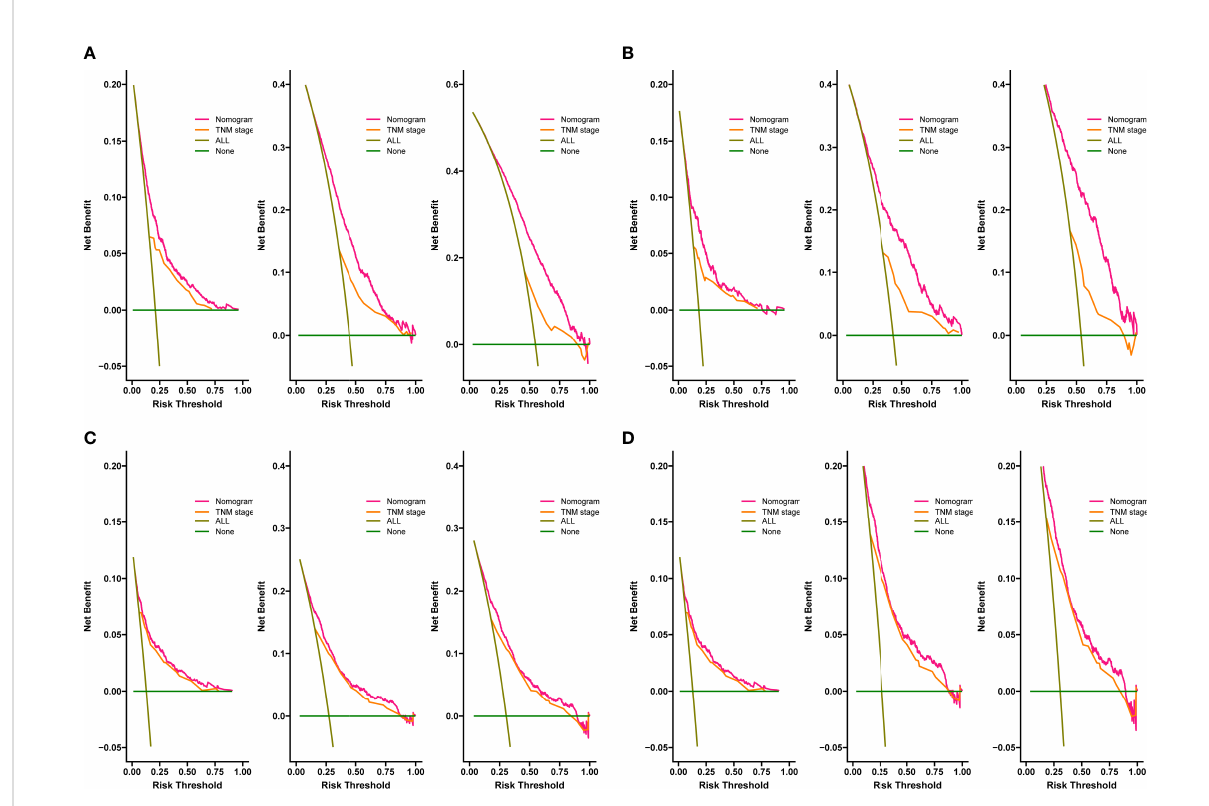
FIGURE 7 Decision curves of the nomogram predicting OS in training cohort (A) and validation cohort (B) . Decision curves of the nomogram predicting CSS in training cohort (C) and validation cohort (D) . The y-axis represents the net bene fi t, and the x-axis represents the threshold probability.